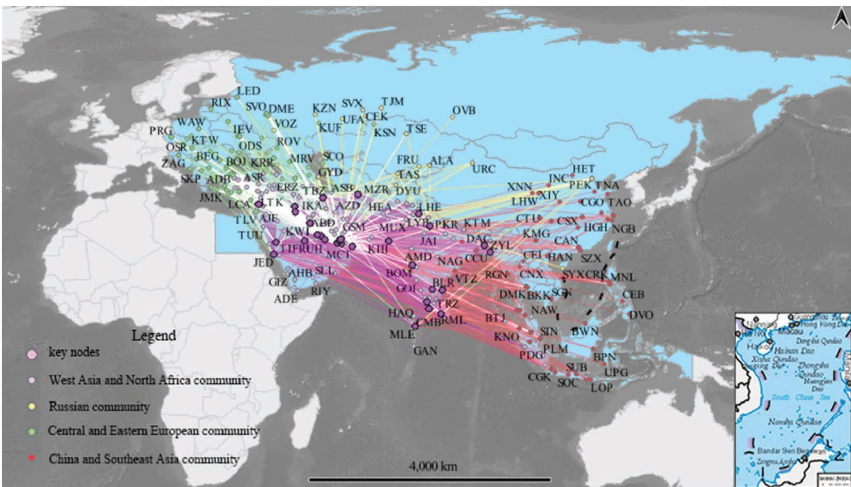
Figure 9: International routes of key node set in West African and North Asian